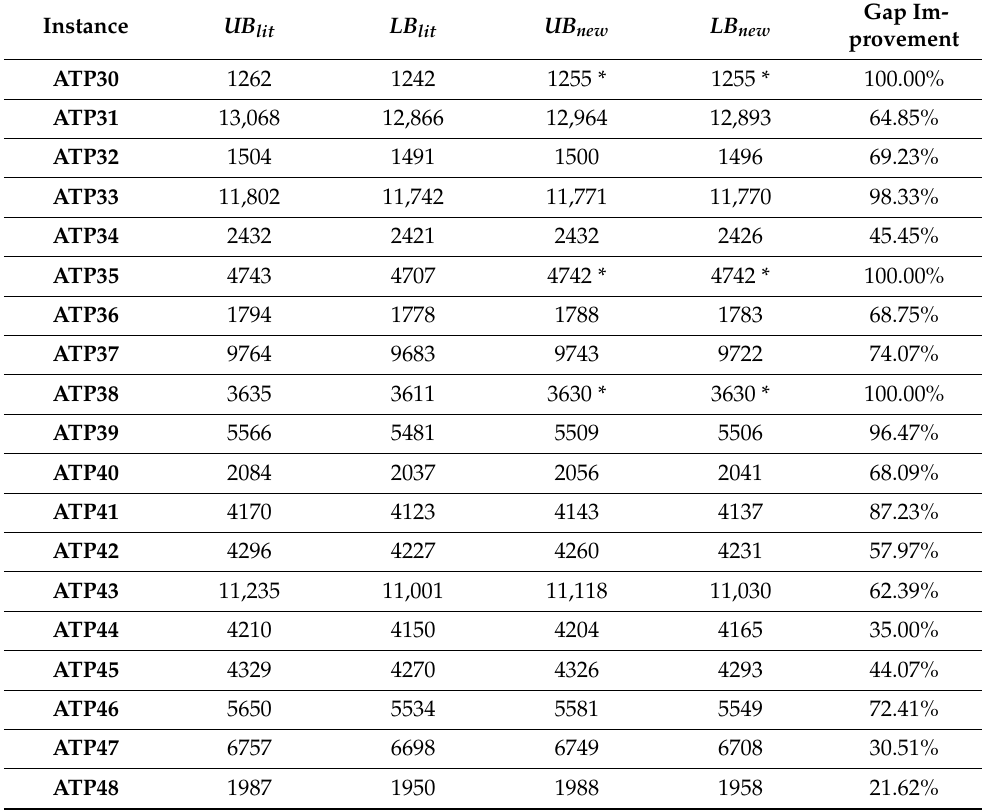
Table 10. Improved benchmark